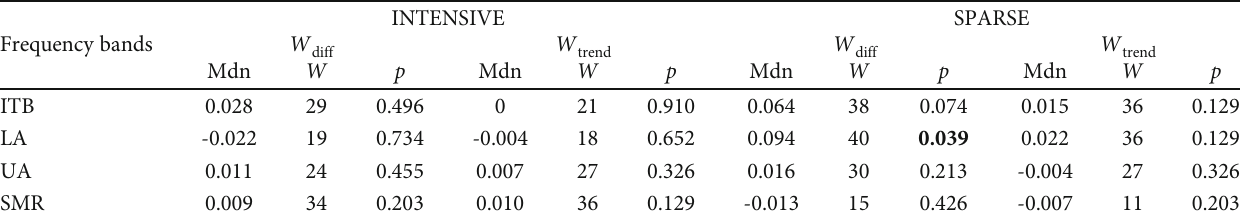
Table 2: Within-group analysis across sessions.